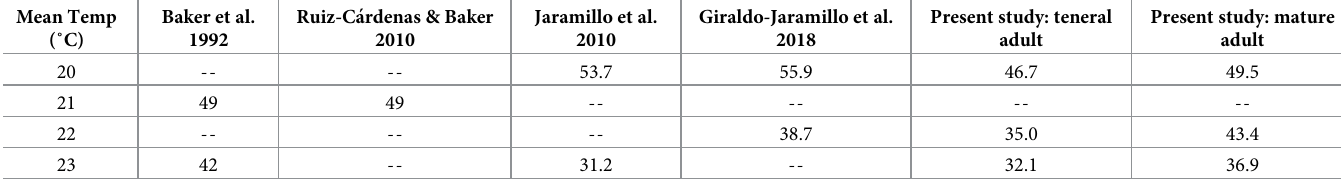
Table 4. Estimated coffee berry borer development times (in days) across a temperature gradient from egg to adult. Times were estimated under field conditions in the present study, as well as in Baker et al. [20] and Ruiz-Ca´rdenas & Baker [21], while Jaramillo et al. [23] and Giraldo-Jaramillo et al. [24] estimated development times in the laboratory under constant